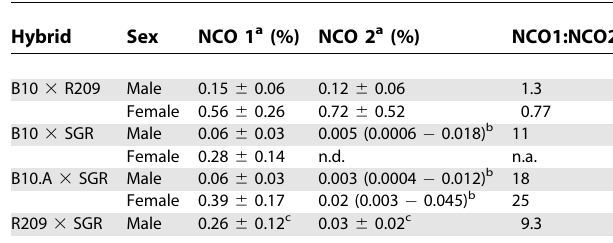
Table 2. NCO Frequencies in Both Orientations at